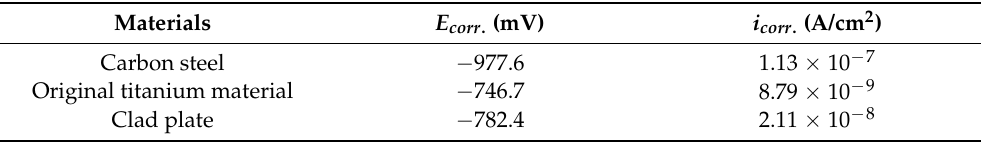
Figure 9. Polarization curves of the three specimens in 3.5% NaCl solution. Table 2. Values of parameters from polarization curves of original Ti material, carbon steel and clad plate (titanium side as working surface) in 3.5% NaCl solution.